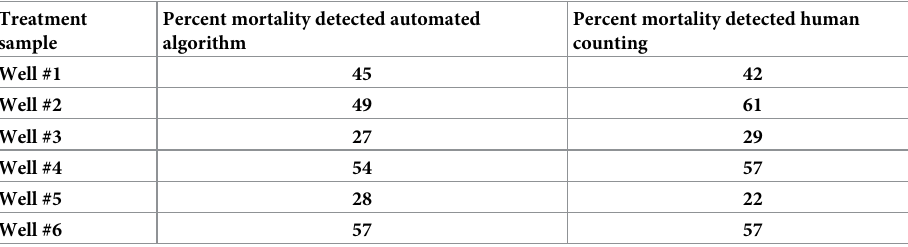
Table 4. Manual counting vs. machine counting results. Treatment